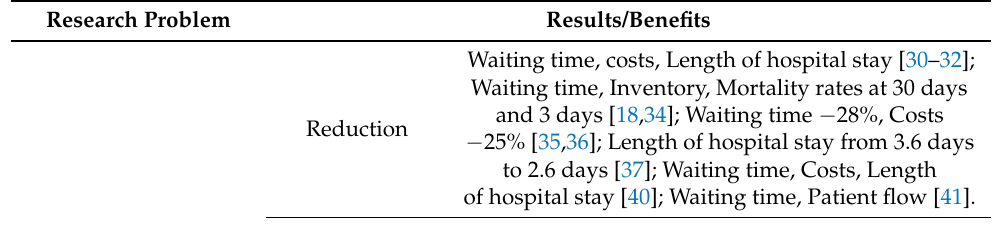
Table 3. Benefits of Lean